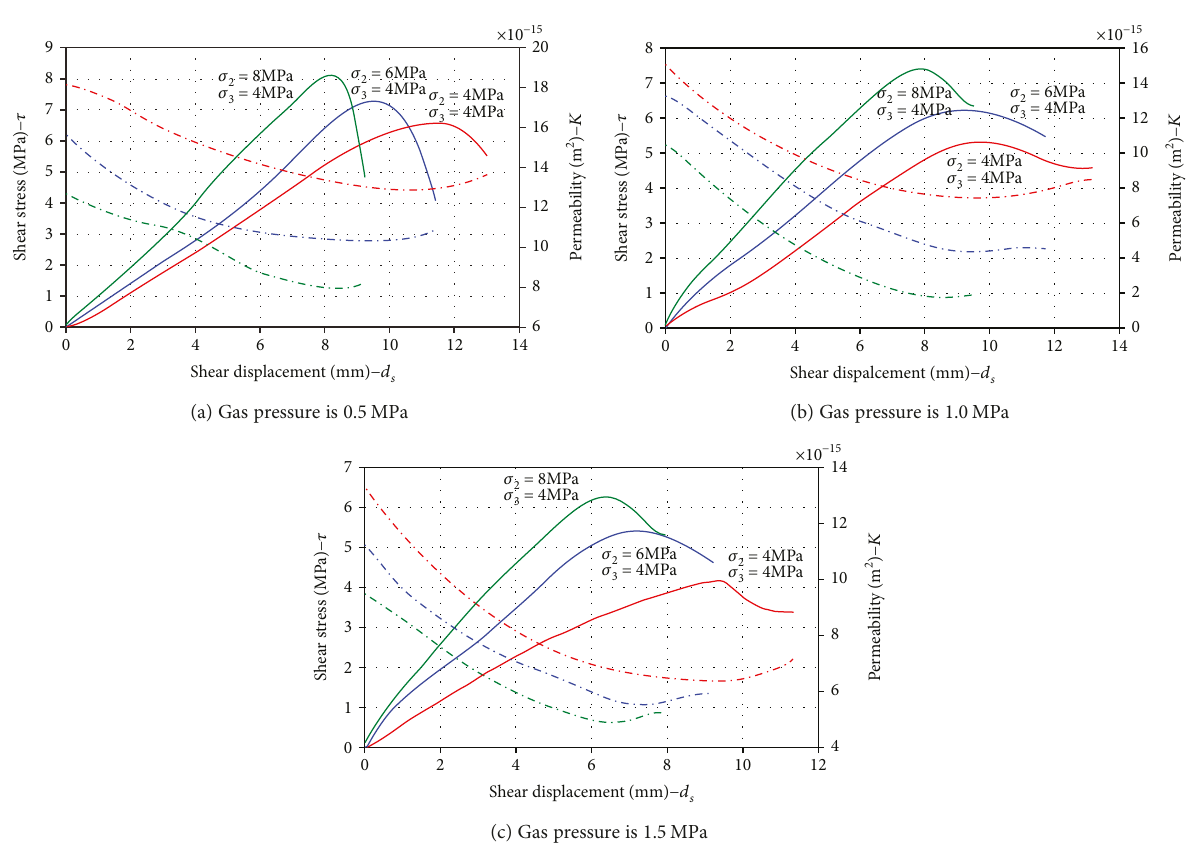
Figure 10: The correlation curves of shear stress and permeability with intermediate principal stresses under di ff erent gas pressure